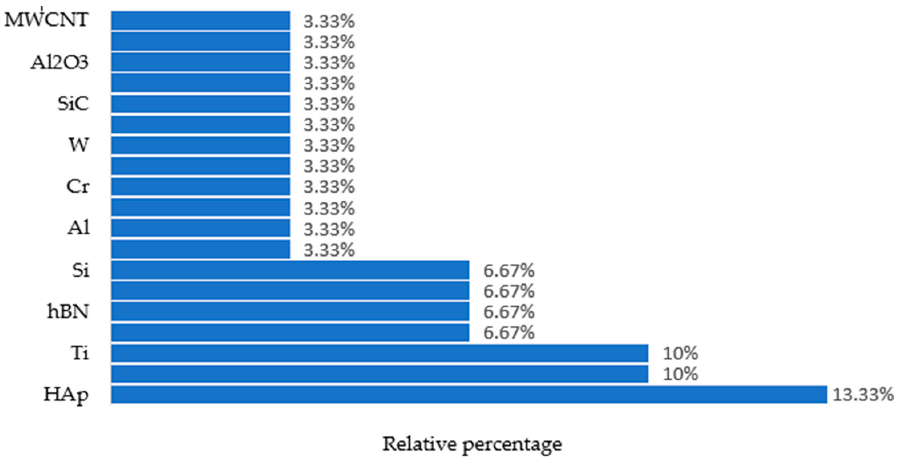
Figure 7. Types of powders used in different EDM processes covered in this study. Hu et al. [53] compared the machined surfaces of SiCp/Al composite obtained by conventional EDM and powder-mixed EDM processes, which are shown in Figure 8. Alu- minum powder was mixed with the kerosene dielectric fluid during the powder-mixed EDM. The average surface roughness values were 0.834 µm and 0.571 µm for conventional EDM and powder-mixed EDM, respectively. The percentages of Al and Si were higher in the powder-mixed EDMed surface. Aluminum powder increased the conductivity of the working fluid, which resulted in an increased sparking gap. Figure 8. Surfaces of machined SiCp/Al composite obtained by ( a ) conventional EDM and ( b ) pow- der-mixed EDM [53]. (With kind permission from Elsevier). The working fluid easily broke down in the presence of powder-mixed dielectric and the discharge time increased at a constant current and pulse width. As a result, the Si percentage increased during the powder-mixed EDM process. The surface roughness of powder-mixed EDMed surface was 31.5% lower than the machined surface obtained from conventional EDM. The conventional EDMed surface consisted of a higher number of cracks and holes due to the higher discharge energy and short circuiting involved in this process. The inter-electrode capacitance effect during conventional EDM resulted in the distribution of irregular and larger shapes of pits. On the other hand, powder-mixed EDM produced a smoother surface with lesser defects. The formation of micro-cracks largely depends on the discharge energies used during the EDM process and effective discharge energy levels at the gap. As the effective discharge energy involved in the powder-mixed EDM process is lower, there was a lower number of cracks on the powder-mixed EDMed surface. The surface micro hardness was 40% higher in the case of the powder-mixed EDM compared with the conventional EDM process.